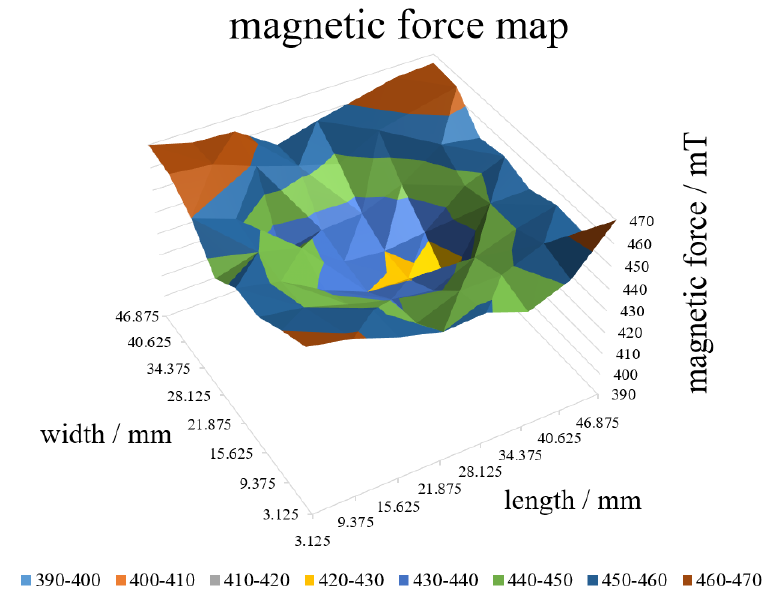
Figure 4. Magnetic force map. The magnetic force was measured at intervals of 6.25 mm along the length and width directions immediately at the surface of the magnet.